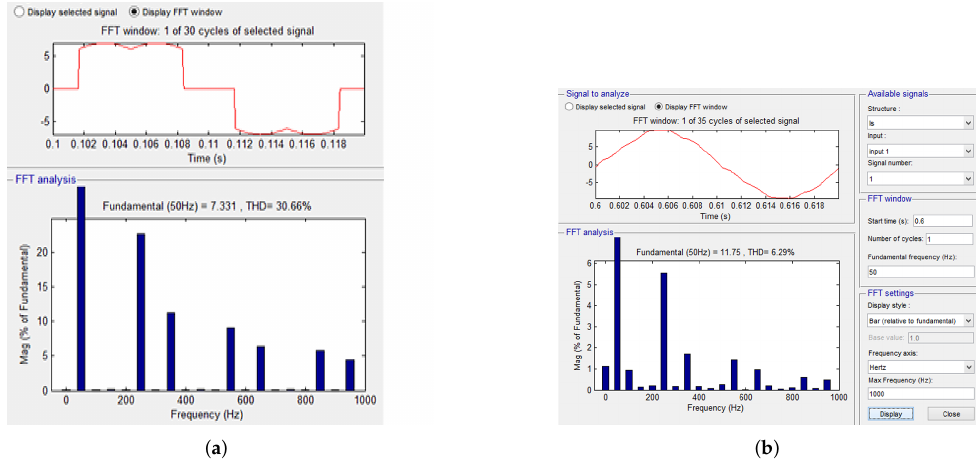
Figure 15. FFT analysis of the system ( a ) before compensation and ( b ) after integrating Microgrid 1. As the next step, Microgrid 2 with a wind RES was interfaced with the main grid, with a higher SoC value. The performance of the IIC with Microgrid 2 when connected to an unbalanced nonlinear diode bridge rectifier load was analyzed. In this case, the smart microgrid system with IIC was also simulated for 2 s; the load was varied at 0.2 s and 0.5 s and the SoC level was varied at 0.1 s, 0.3 s, and 0.4 s. Thus, the source current and the compensating current vary according to the changes, as in Figure 16. Thus, when both the microgrids are integrated into the main grid, the FFT analysis after compensation is shown in Figure 17. Since the SoC level of Microgrid 2 was higher than Microgrid 1, the THD value after compensation was found to reduce to 5.58%.